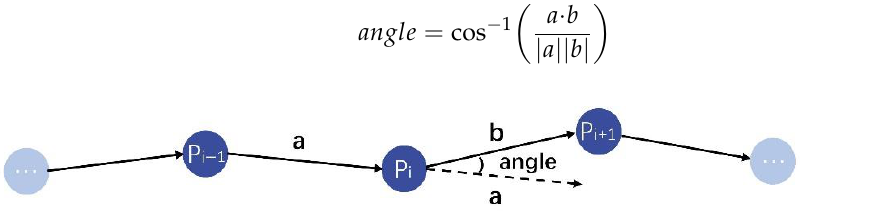
Figure 3. Schematic diagram of angle calculation for trajectory point p i . a is the vector between p i − 1 and p i , b is the vector between p i and p i + 1 .